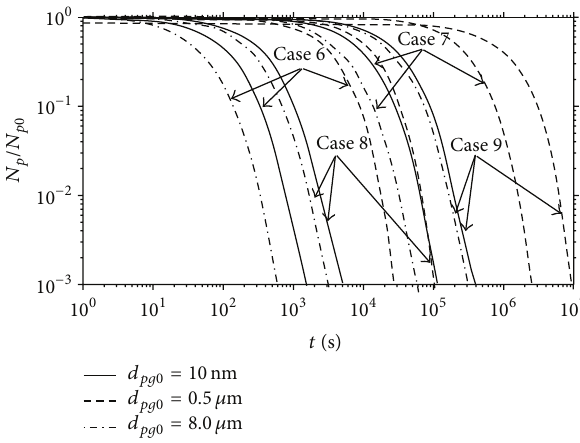
Figure 2: Evolution of particle geometric mean diameter as time progresses for Cases 2–5.